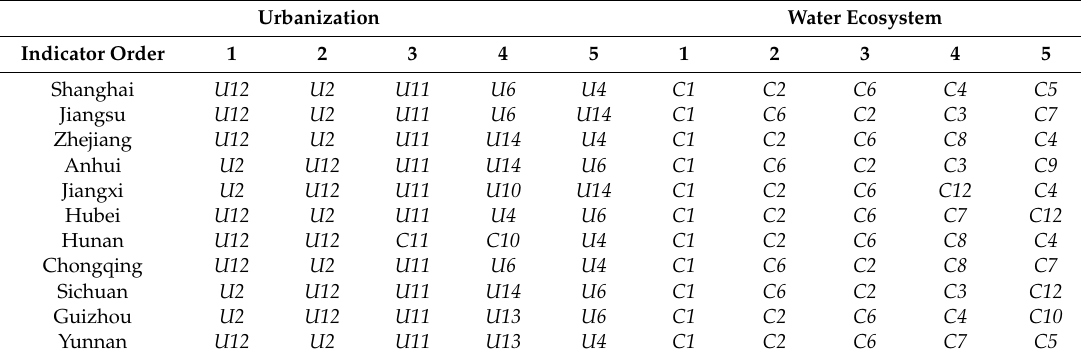
Table 5. The main obstacle indicators in urbanization and water